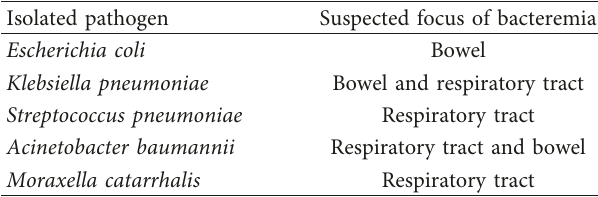
Table 2: Blood culture